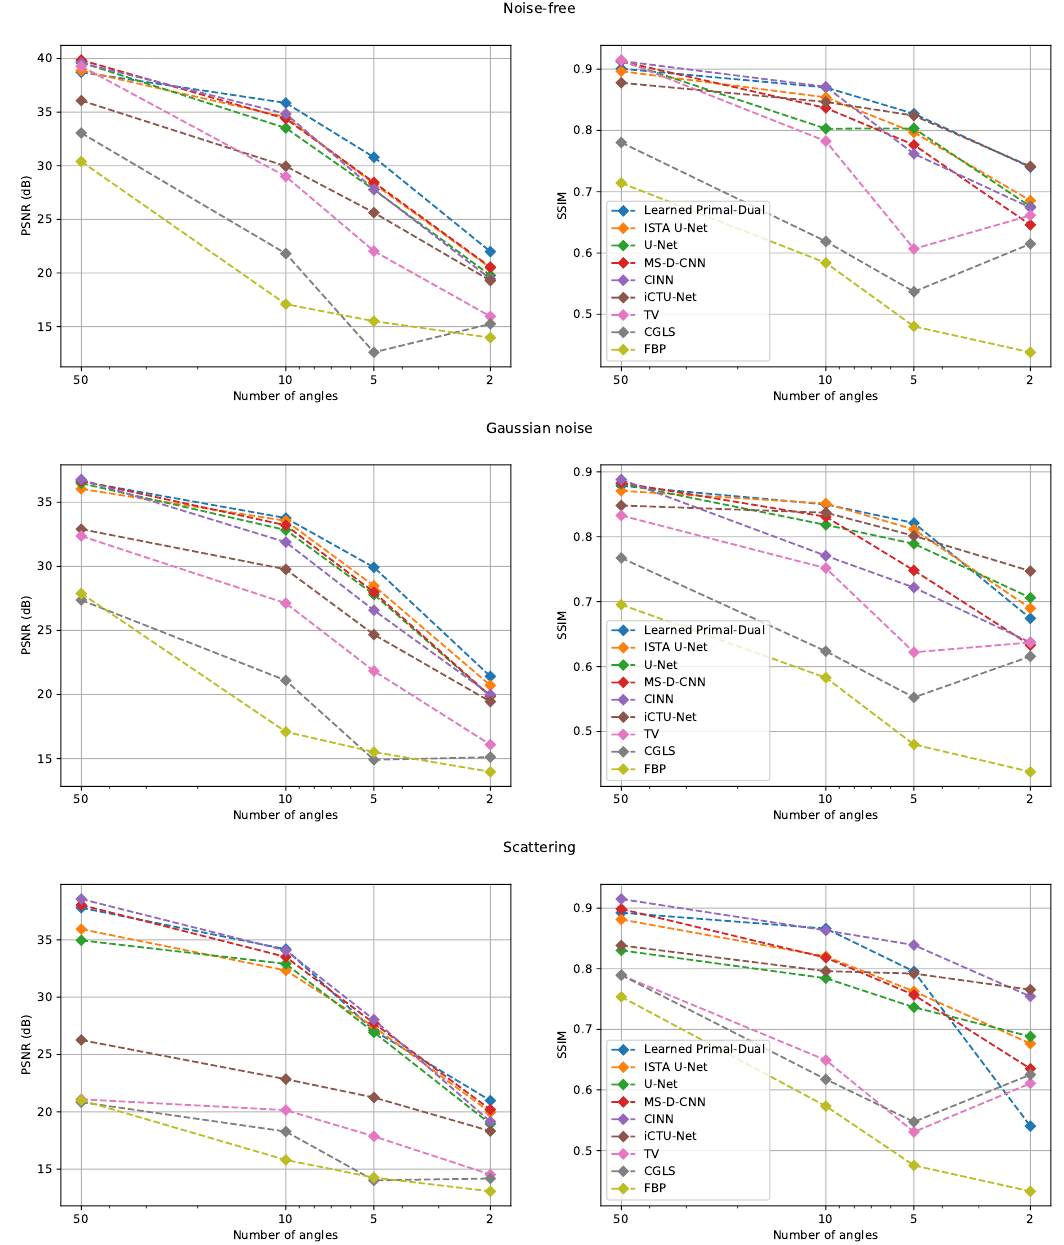
Figure A7. PSNR and SSIM depending on the number of angles on the Apple CT datasets.